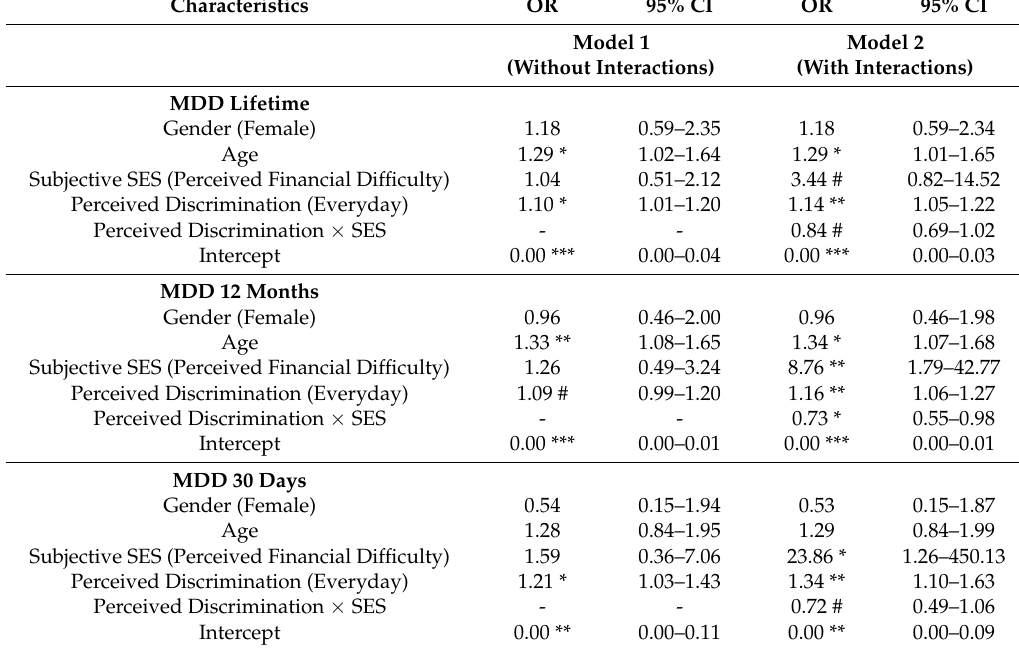
Table 3. Summary of logistic regression on the multiplicative effects of perceived discrimination and subjective SES on MDD ( n = 810).